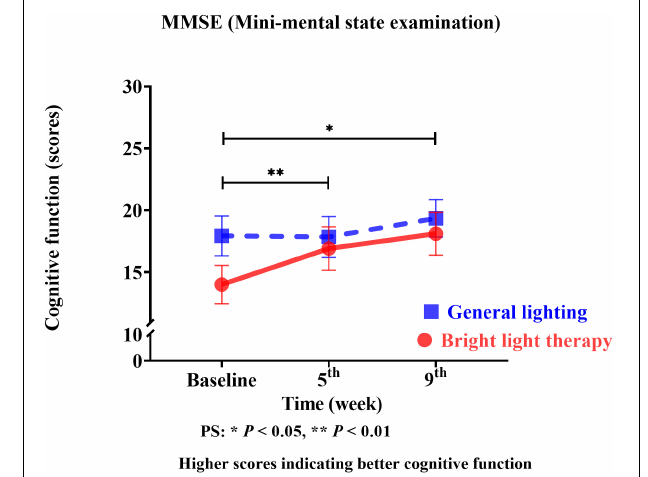
FIGURE 3 | The experimental group showed significant improvement in the NPI (Wald’s test = 12.59, P < 0.001; Wald’s test = 10.39, P = 0.001) from baseline to the 5th and 9th weeks compared with the comparison group.